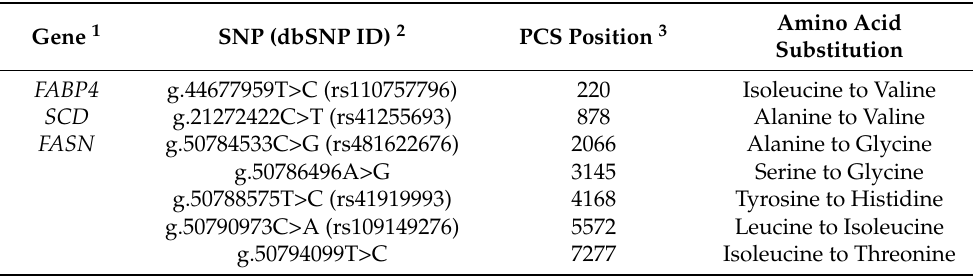
Table 2. FABP4 , SCD, and FASN gene polymorphisms, protein-coding sequence positions, and non- synonymous amino acid